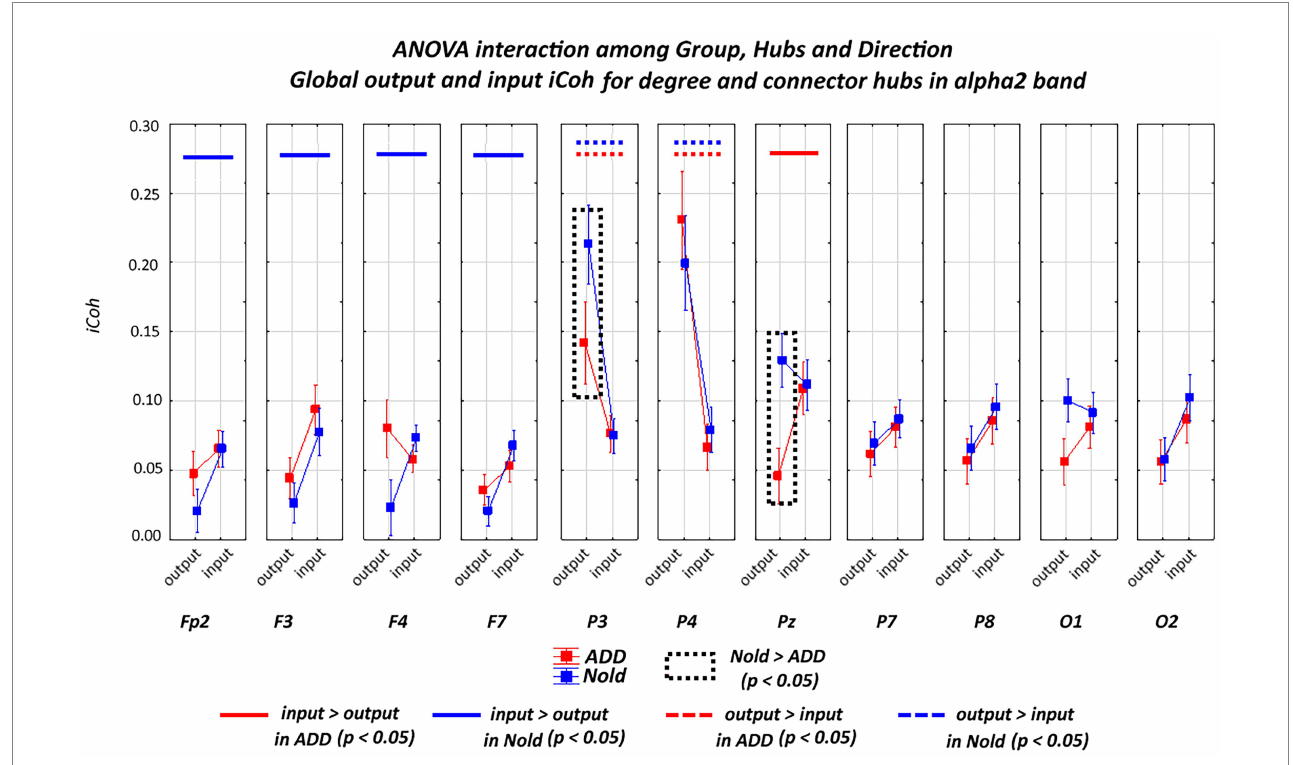
FIGURE 5 Global isolated lagged effective coherence (iCoh) values (mean across subjects ± SEM) in the alpha 2 frequency band within electrodes classified as substantial degree or connector hubs relative to a statistically significant ANOVA interaction (F [10, 750] = 2.42, p < 0.05) among the group (Nold and ADD), hubs (Fp2, F3, F4, F7, P3, P4, Pz, P7, P8, O1, and O2), and direction (output and input) factors. No statistically significant outliers were found according to Grubbs’ test ( p <